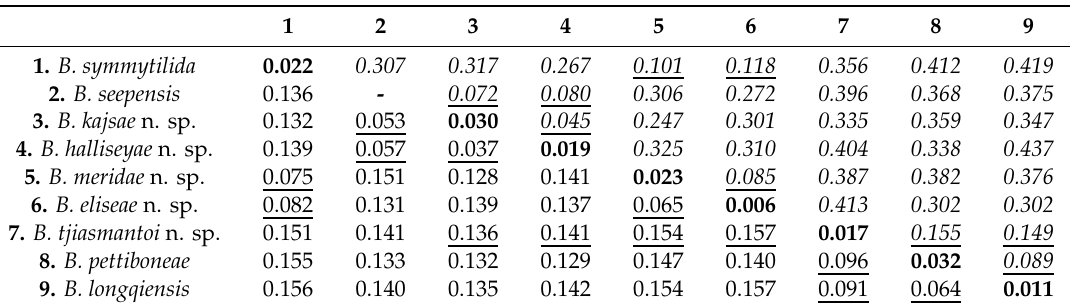
Table 2. Minimum uncorrected interspecific distances (lower diagonal series) and minimum GTR + I + G corrected interspecific distances (upper diagonal series, italics) for Branchipolynoe species COI data. The maximum uncorrected intraspecific COI distances, where available, are shown as the diagonal, bold. Underlined distances are discussed in the text.